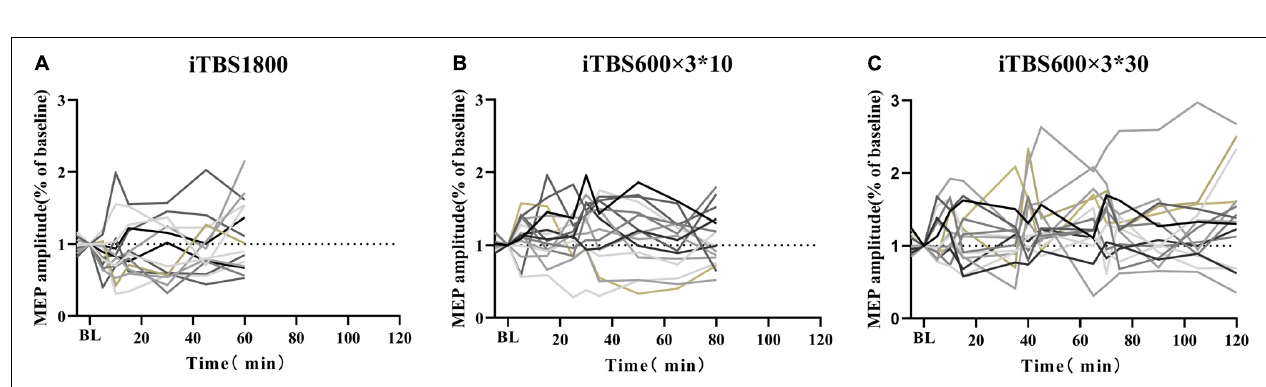
Frontiers in Neuroscience |